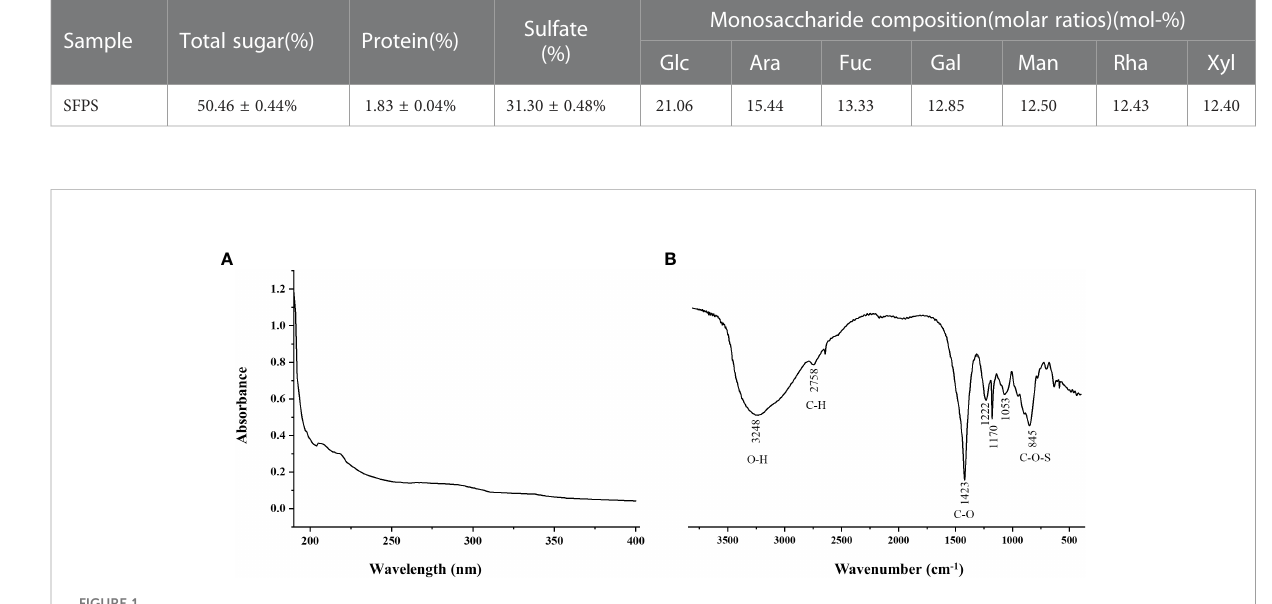
FIGURE 1 UV Spectrum (A) and FT-IR spectrum (B) of